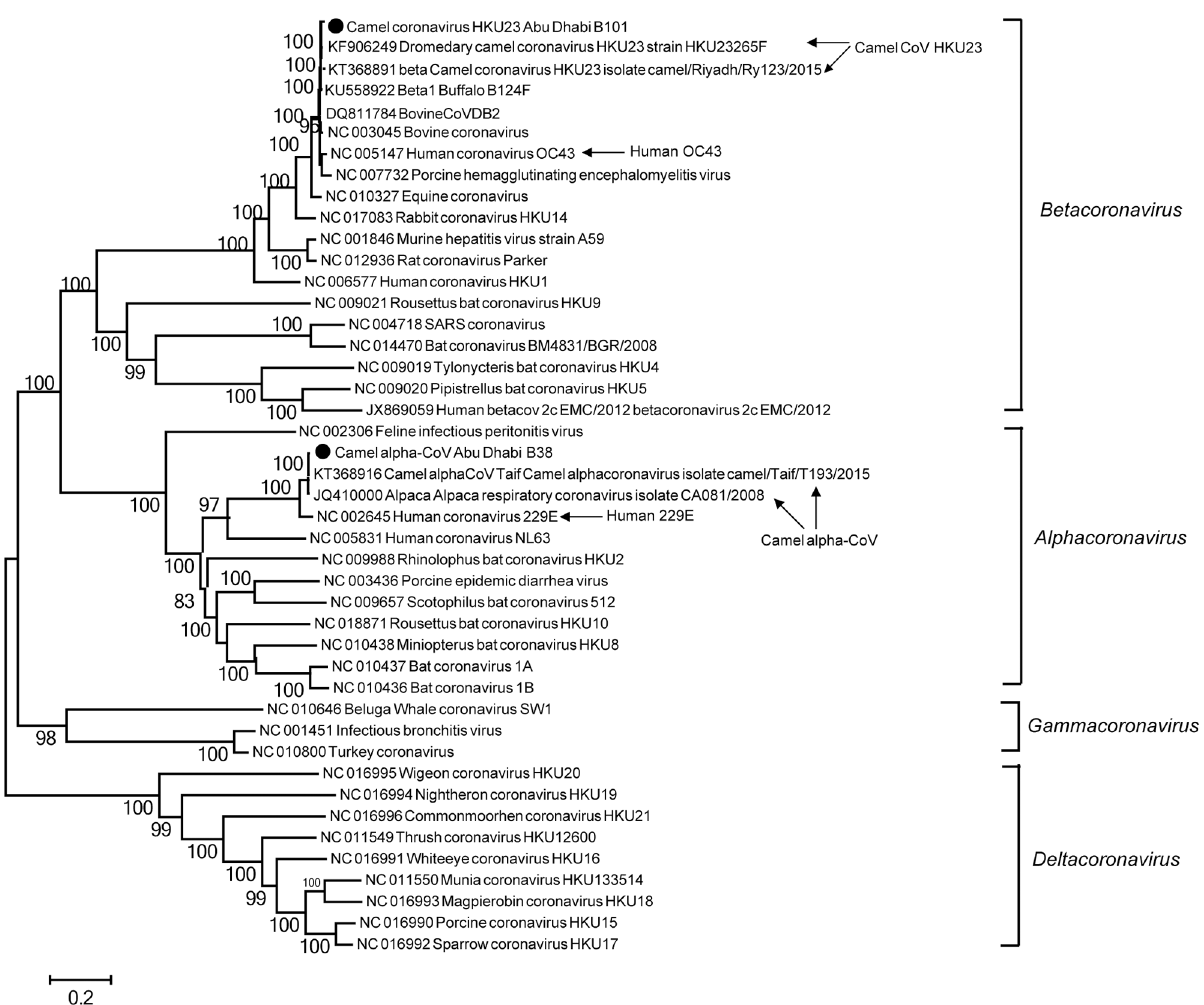
Fig 2. Phylogenetic analysis of the camel coronaviruses. Maximum likelihood phylogenetictree was estimated using completeor near completegenomesfrom 42 previously published coronavirussequences,one representative camel alpha-CoVAbu Dhabifull genome,and one representative camel CoV HKU23 Abu Dhabigenome ( (cid:21) 99.5%genomecoverage) from this study. The four generain Coronavirinae are labeledaccordingly. Previouslypublishedcamel alpha-CoVand camel CoV HKU23 as well as the human229E and OC43 CoVs are indicatedby arrows. Camel virus sequencesidentified in this study are highlightedby solid circles. The scale bar indicates the estimated number of nt substitutions per site and the bootstrap values ( (cid:21) 80) are indicated.